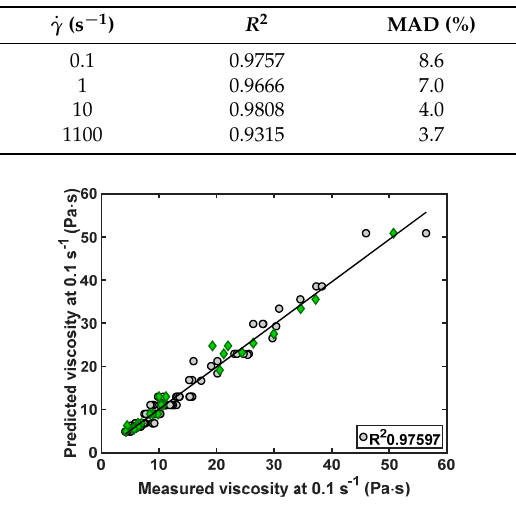
Figure 5. Predicted viscosities against measured viscosities at 0.1 s − 1 . Training and validation: grey circle; test: green diamond.